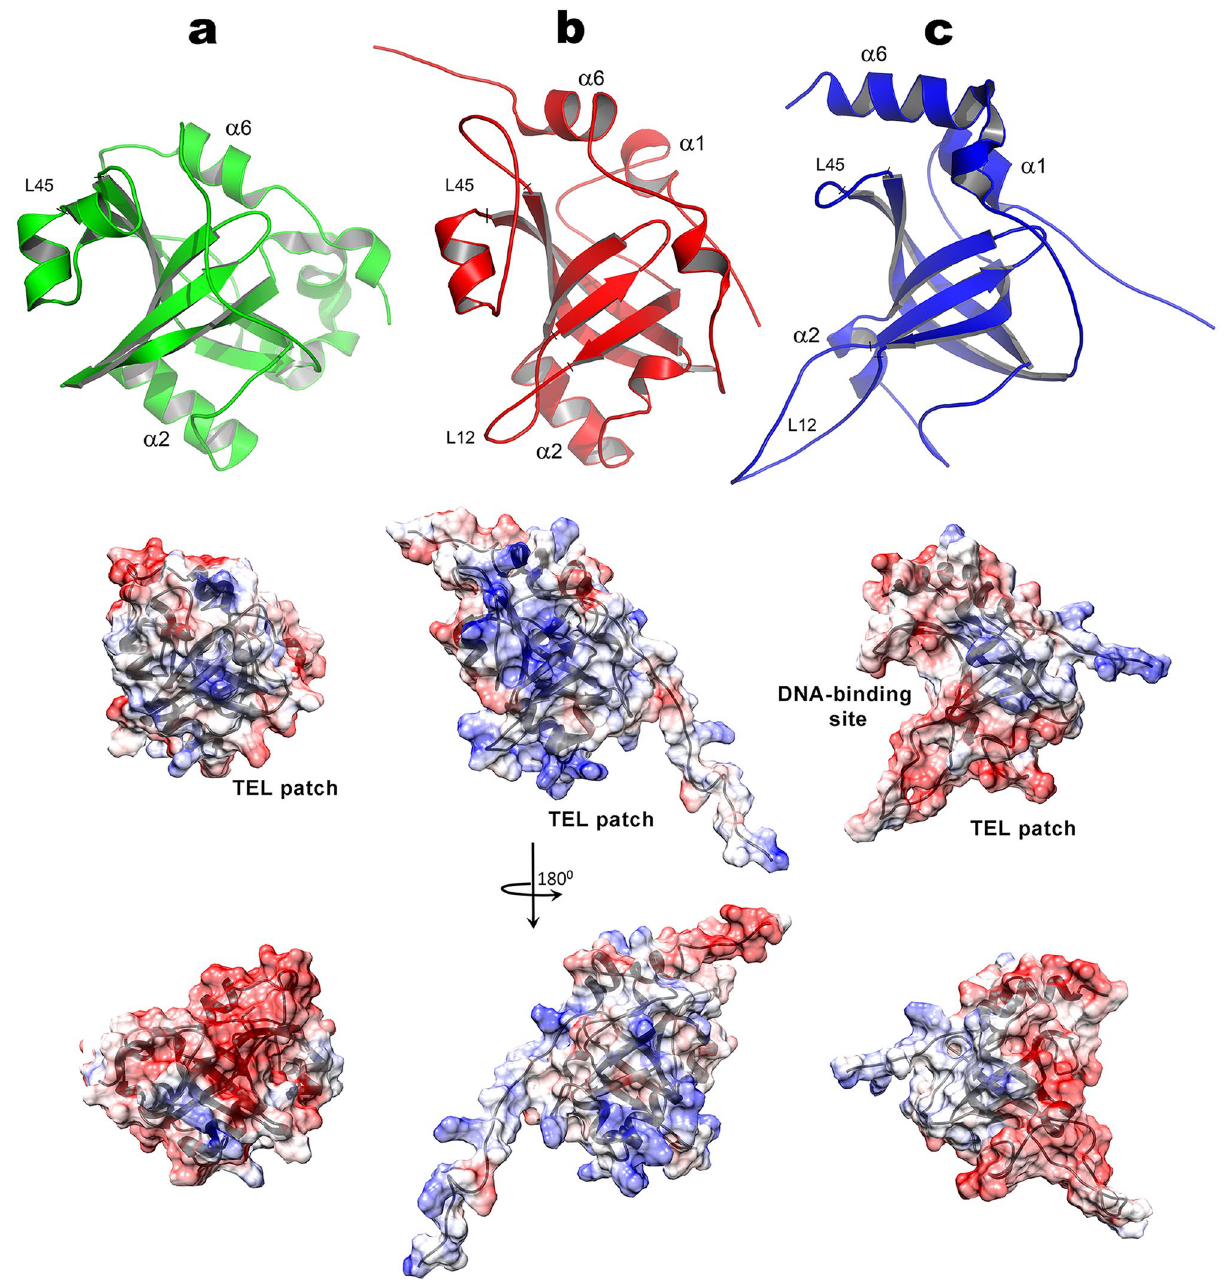
Figure 7. Structures (top) and Coulomb charge distribution over the molecular surfaces (bottom) of Est3 from ( a ) Saccharomyces cerevisiae (PDB ID 2M9V 42 ), ( b ) Hansenula polymorpha (PDB ID 6Q44, this work), and ( c ) human TPP1 (PDB ID 2I46 44 ). Images were made using PyMOL v. 2.3 (Schrodinger,